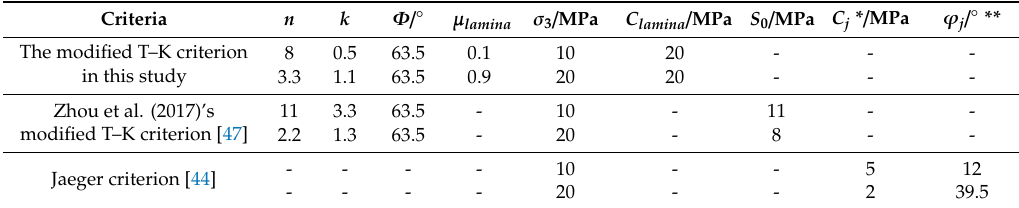
Zhou et al. (2017)’s modified T–K criterion [47]